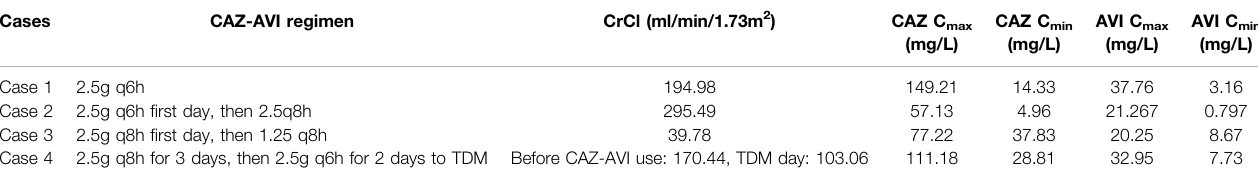
TABLE 3 | Renal function and blood concentration of CAZ-AVI detected by